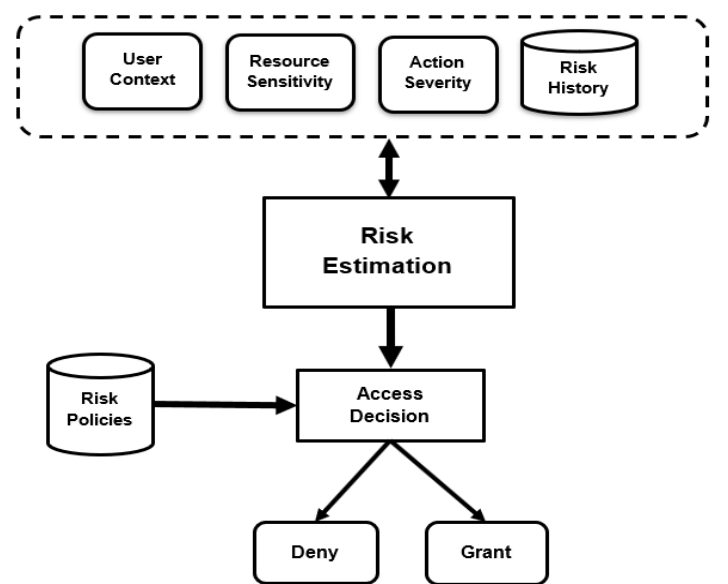
Figure 1. Dynamic risk-based access control mode.